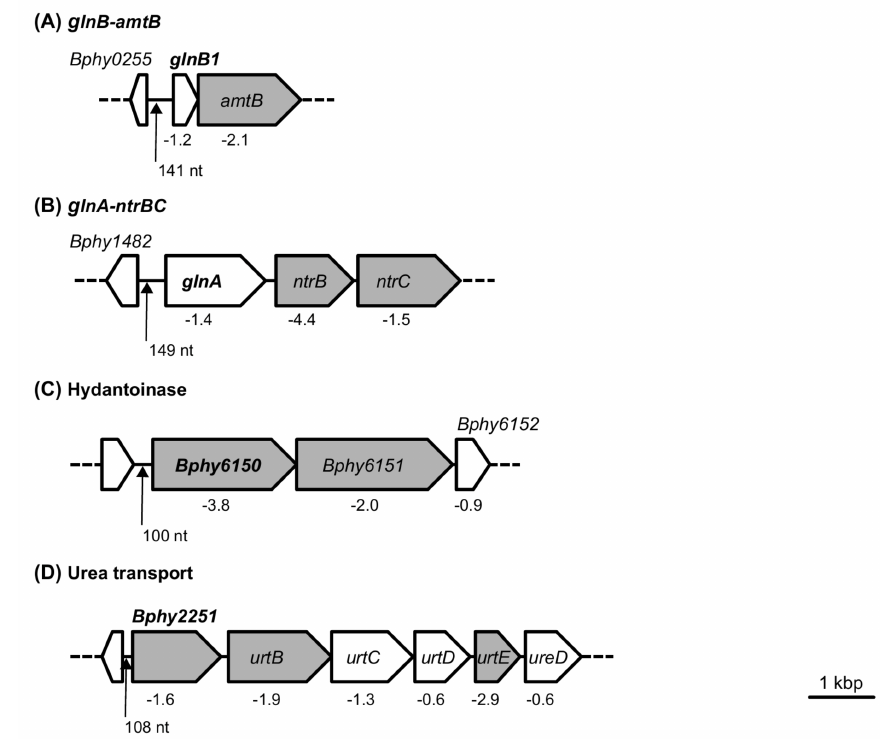
Figure 3. Selected P. phymatum gene clusters harboring a putative but high-scoring RpoN binding box in their promoter region. The operon containing the ammonium transporter gene amtB ( A ), the operon containing the 2CRS NtrBC ( B ), the genes coding for a hydantoinase ( C ), and the cluster for urea transport ( D ) are shown. Gene names are indicated in italics, while the genes containing an RpoN binding box upstream are shown in bold. Genes present among the top 500 regulated genes (Table S3) are colored in grey, and their log 2 fold expression changes are shown below. Black arrows indicate the position of the RpoN box; the distance (in nucleotides) from the middle of the box to the translation start site is indicated below the